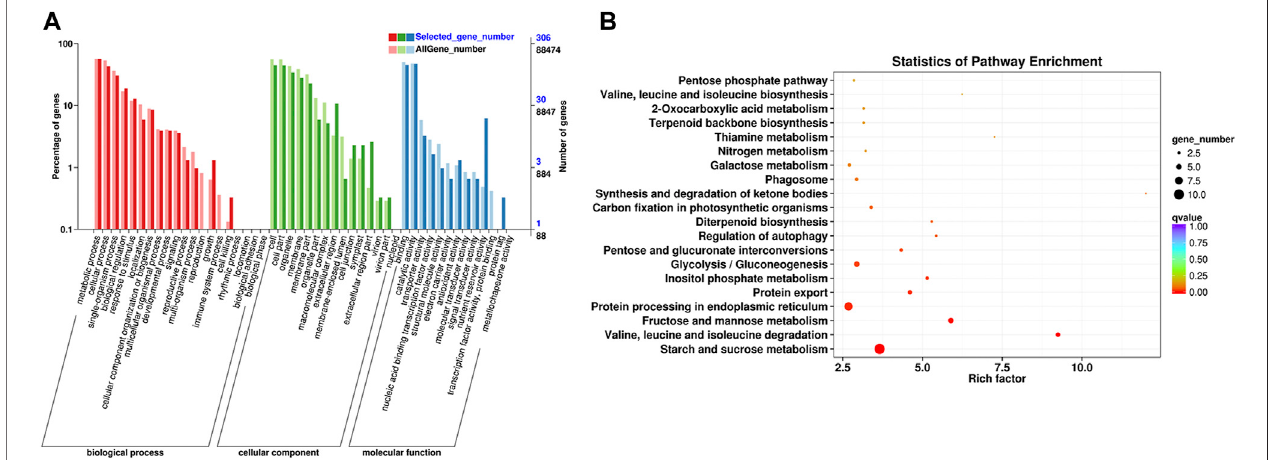
FIGURE 6 | Functional annotation of the DEGs based on GO and KEGG pathway enrichment analyses. (A) GO classi fi cation of the DEGs. (B) KEGG classi fi cation of the DEGs.